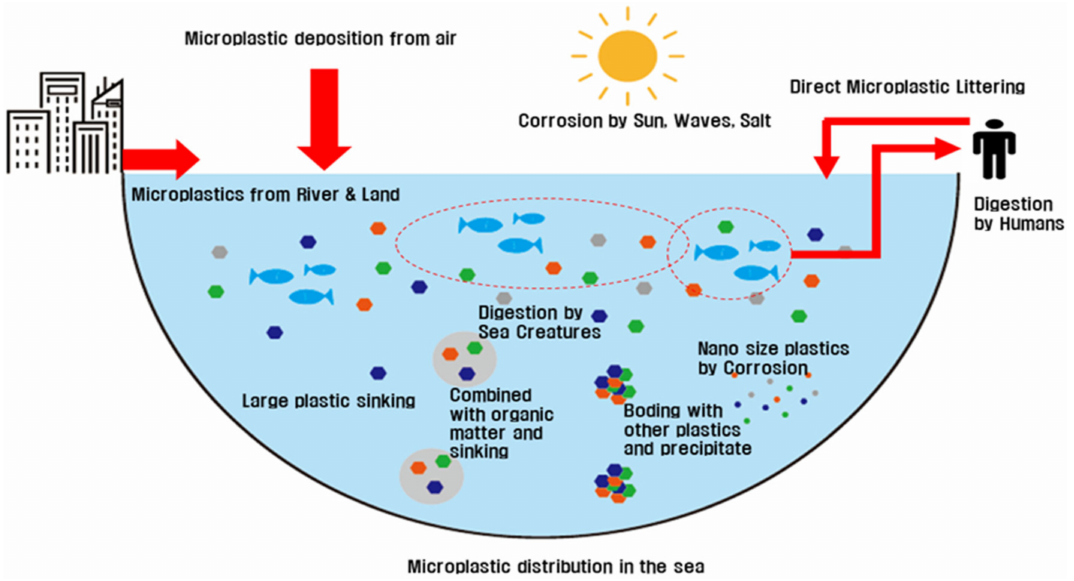
Figure 2. Microplastic contamination distribution pathway in the sea.